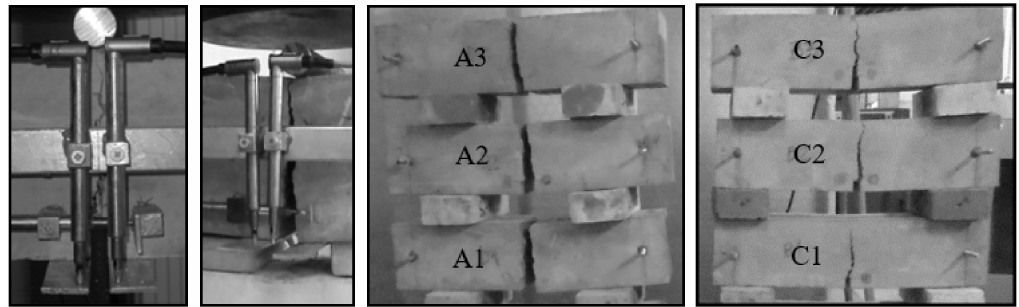
Figure 14. Damaged beams; from left: beam C2; beam A1 (no fibres); series A; series C.